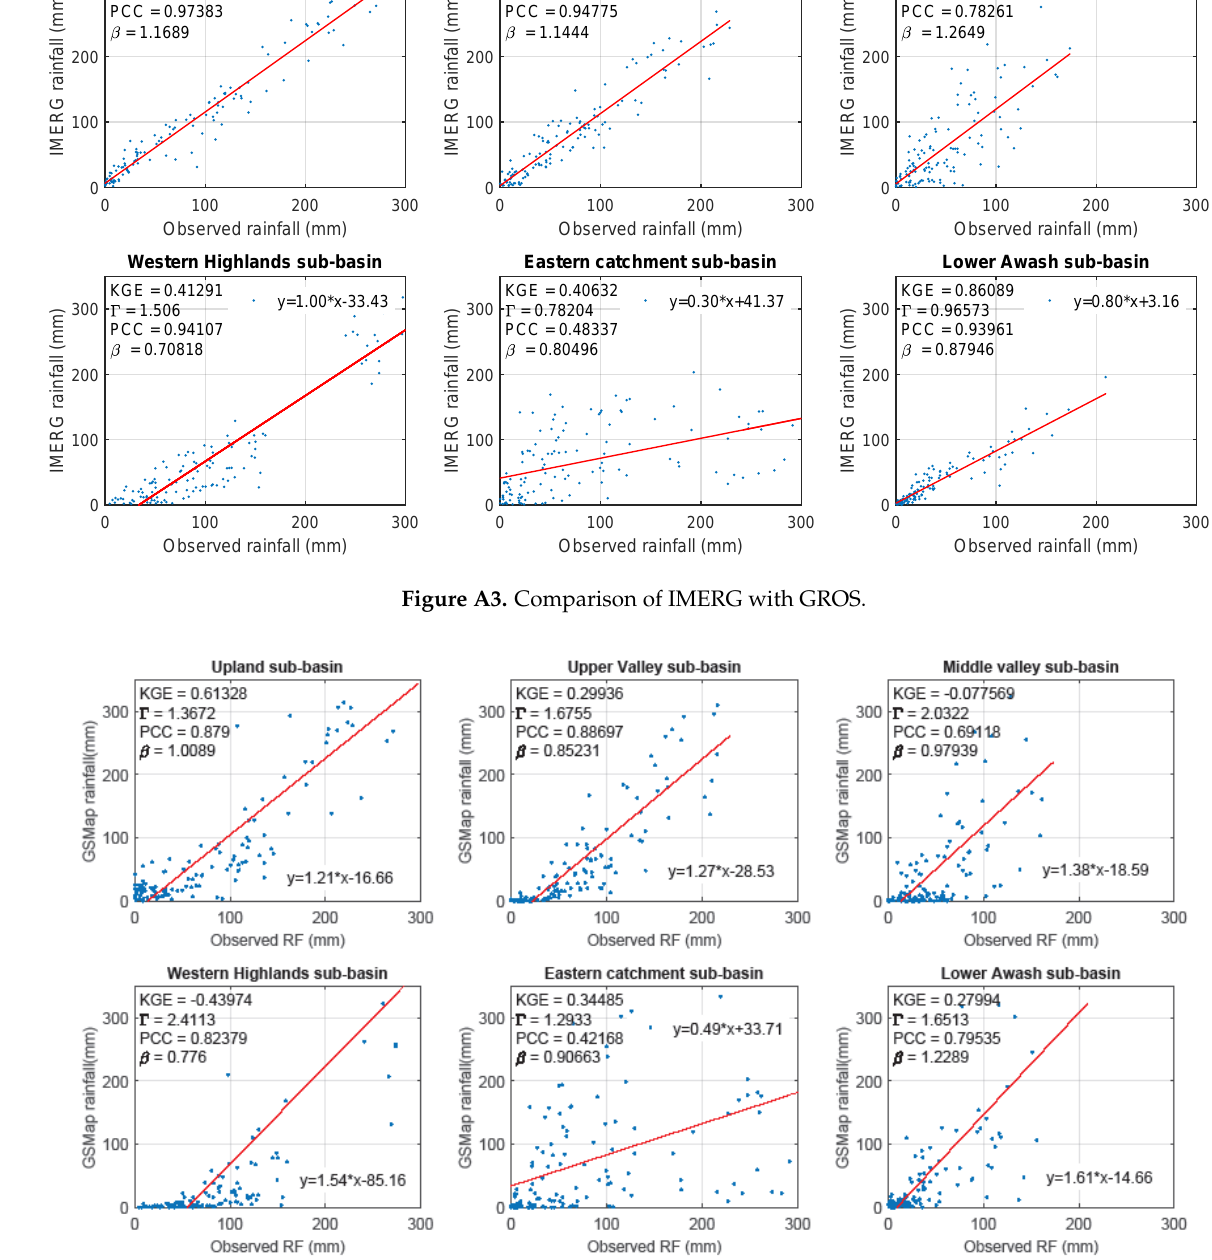
Figure A4. Comparison of IMERG with GROS.